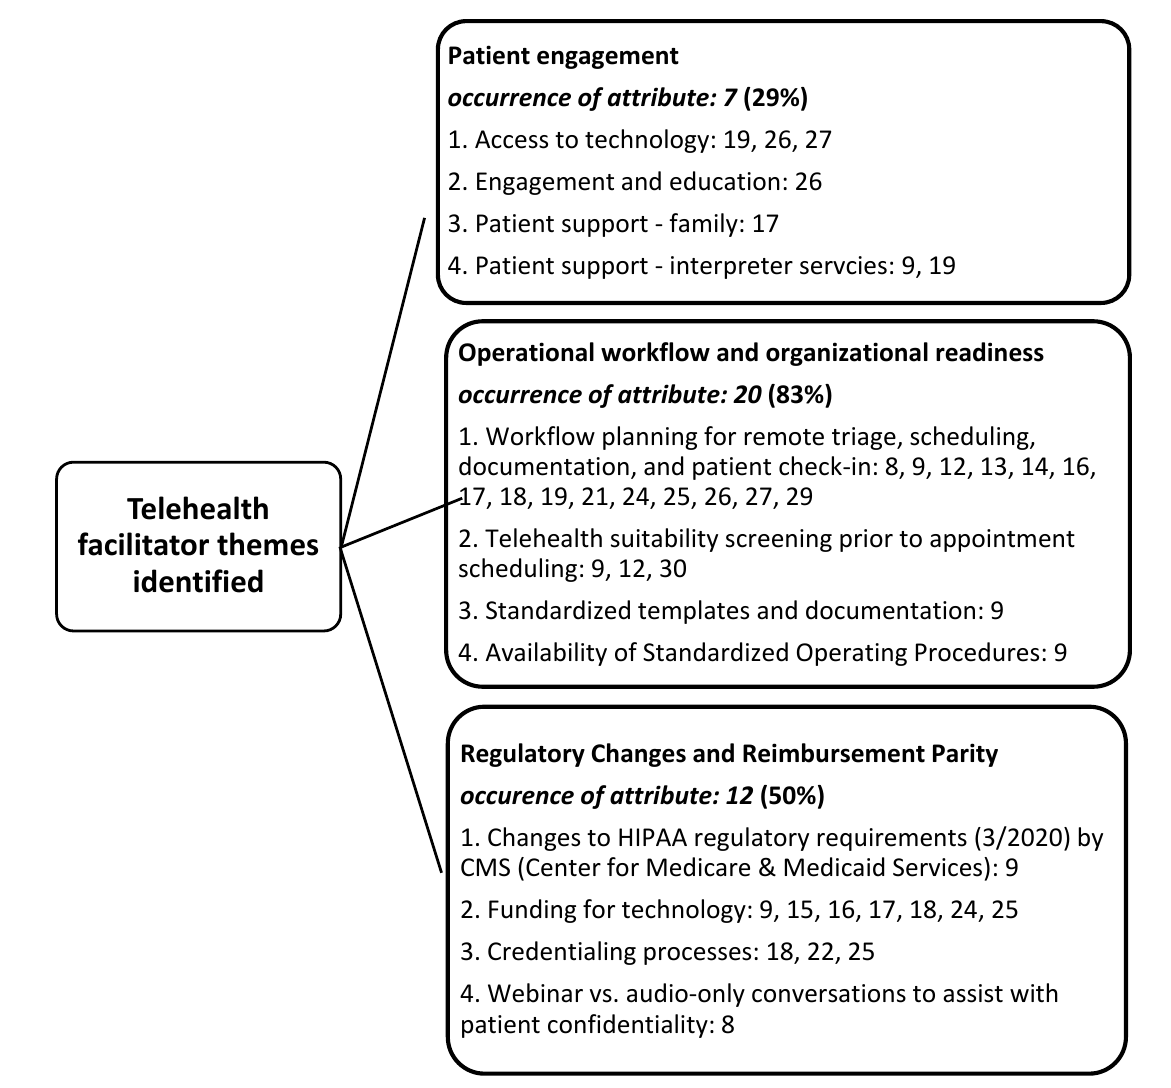
Figure 2. Identified themes (constructs) identified as facilitators to the implementation of telehealth during the COVID-19 pandemic in the United States.